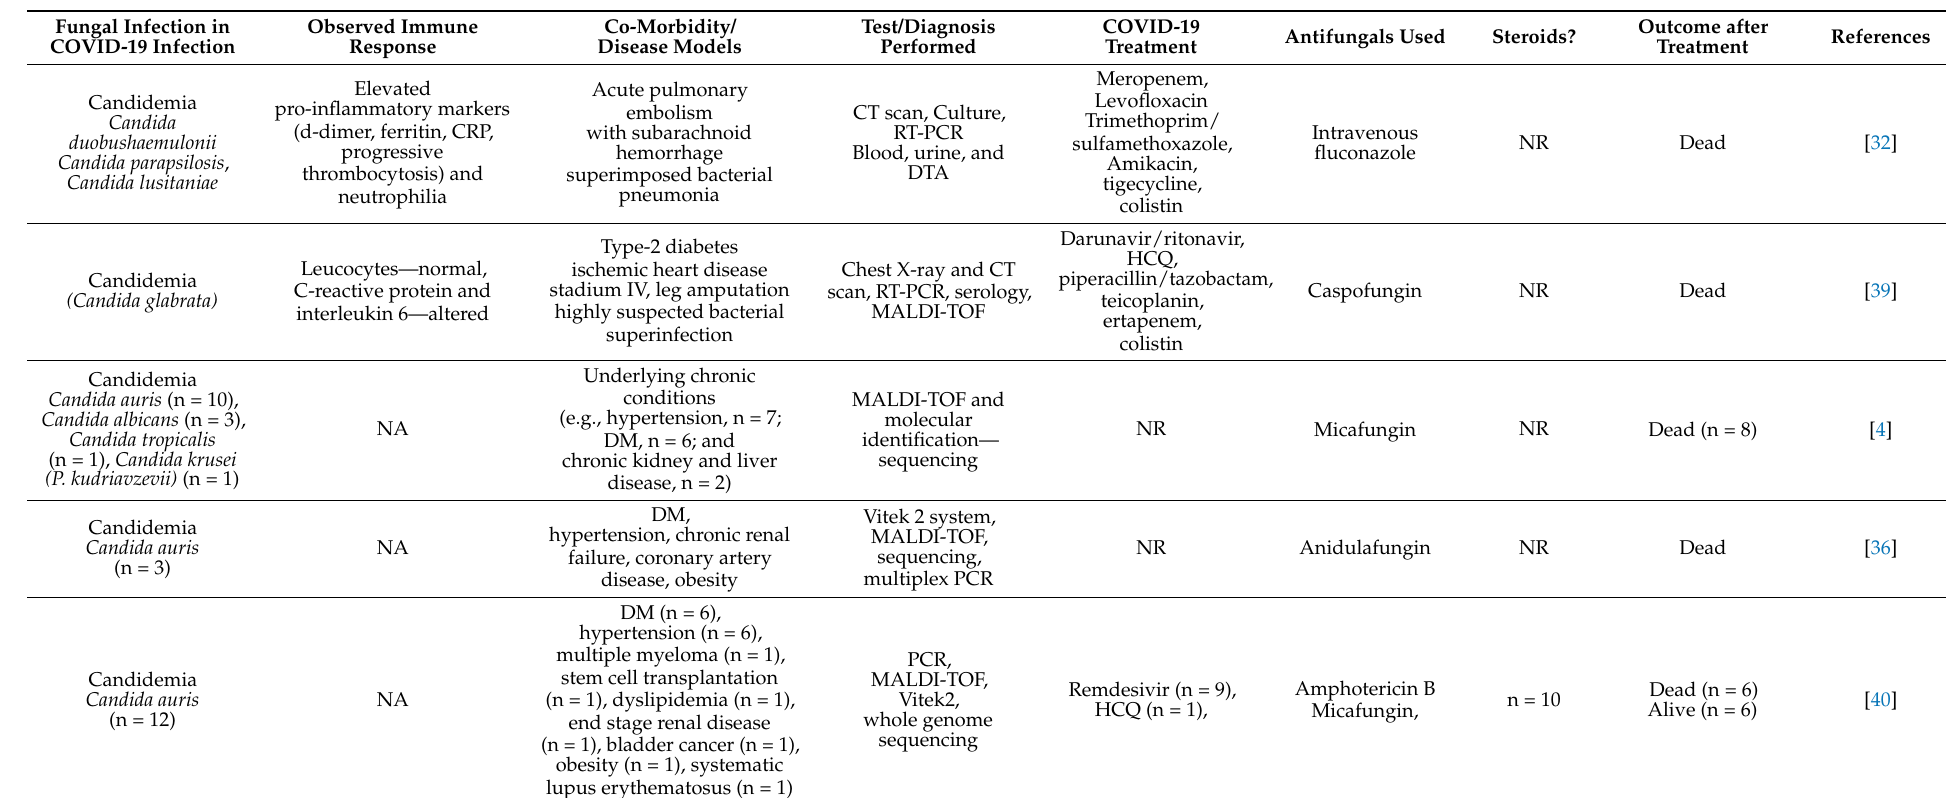
Table 1. Clinical characteristics of COVID-19 patients reported with